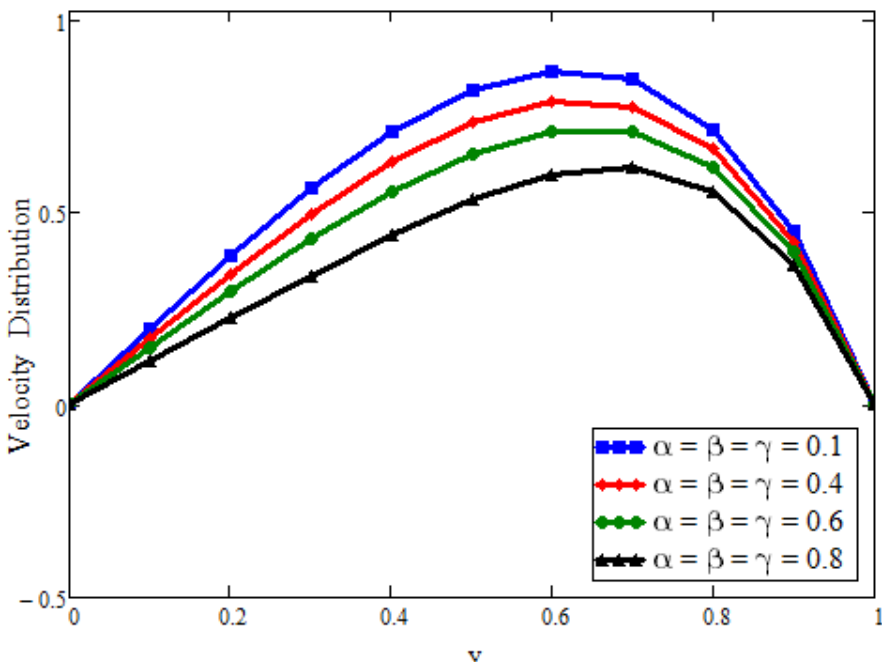
Figure 5. Velocity distribution against y due to fractional parameters 𝛼, 𝛽, 𝛾 for small time, when t = 0.3 , Pr = 6.2 , 𝜙 (cid:3035)(cid:3041)(cid:3033) = 0.04, Gr = 25, M = 0.1.